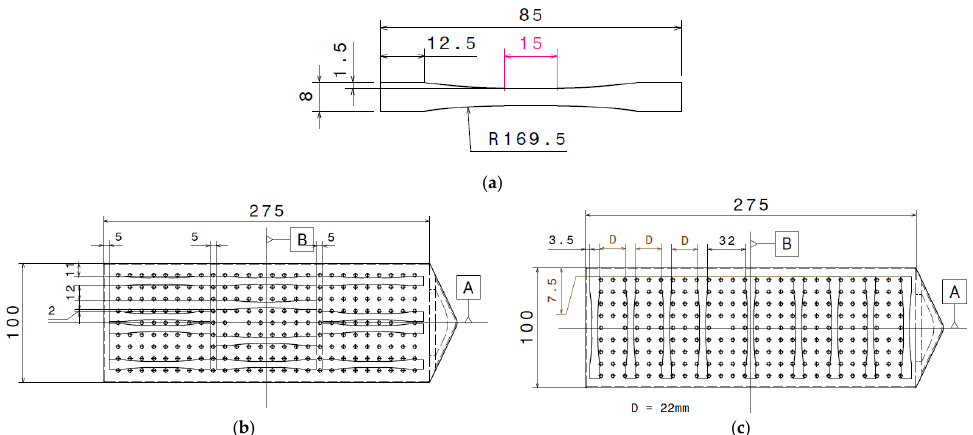
Figure 3. ( a ) Tensile sample shape and dimensions as well as localizations of tensile samples in the ( b ) longitudinal and ( c ) transverse directions.